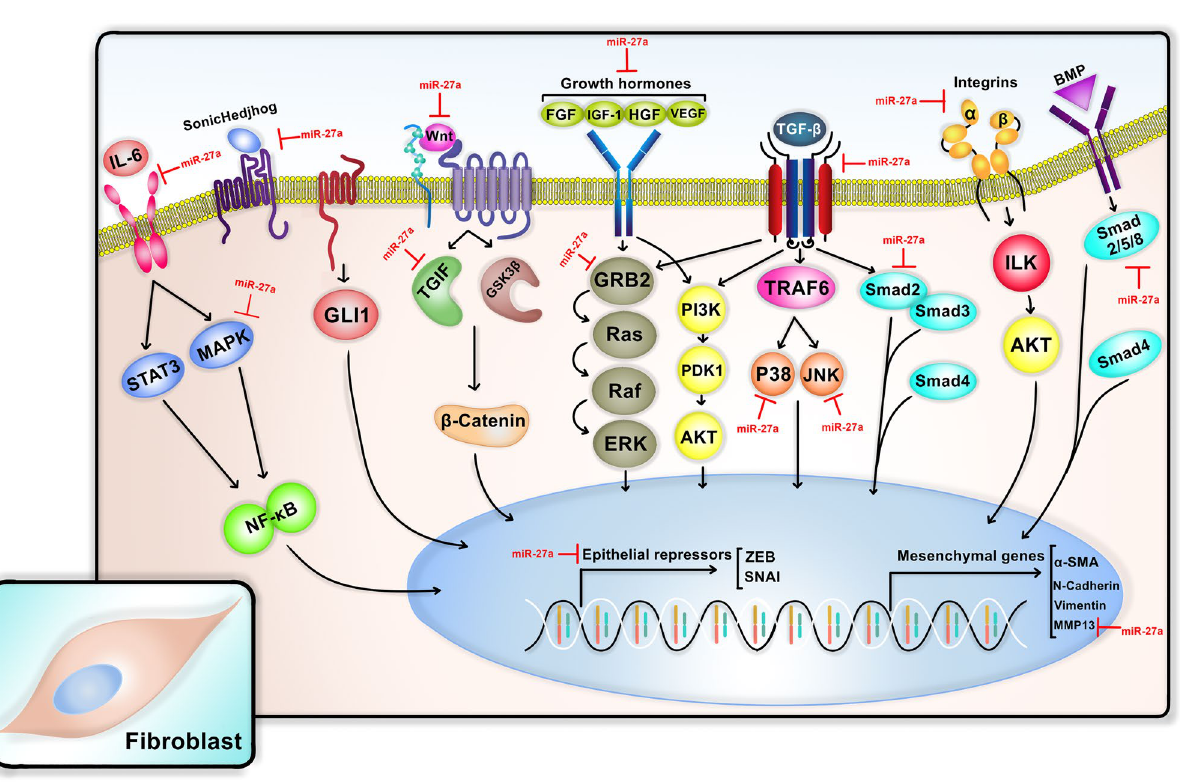
Figure 4. Predicted targets of miR-27a in the EMT pathway. miR-27a could interact with and target multiple gene transcripts contributing to the EMT signaling pathway which eventually results in the differentiation of fibroblasts into myofibroblasts; these cells are responsible for the development of fibrosis which is a key feature of